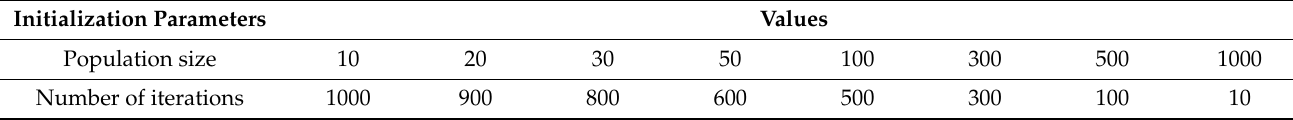
Table 12. Population size and number of